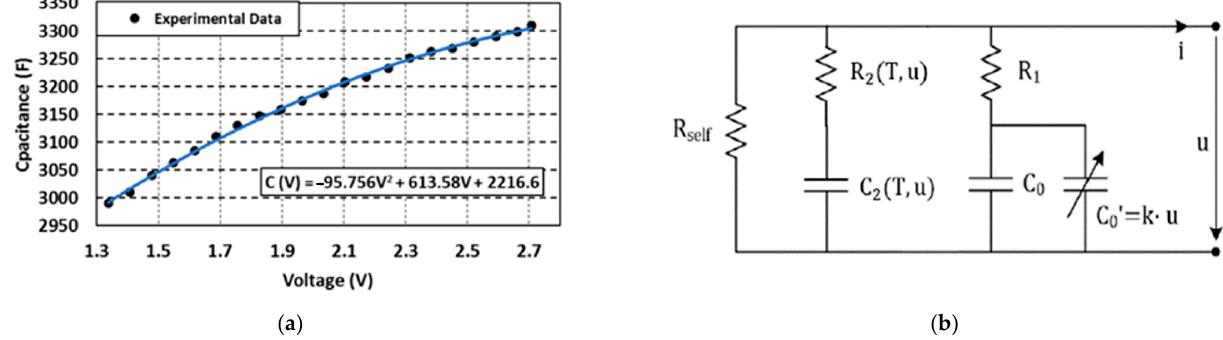
Figure 2. ( a ) Evolution of the capacitance value as a function of the voltage in the BCAP3000 cell and ( b ) schematic of the electrical circuit used to model the behavior (voltage) of the supercapacitors (SCs).